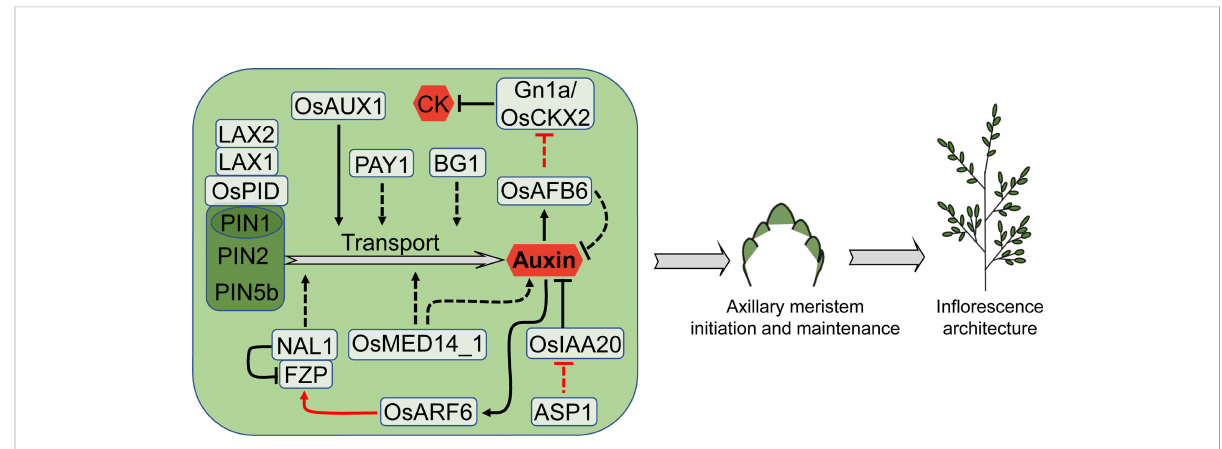
FIGURE 5 Factors involved in auxin-mediated regulation of rice in fl orescence architecture. Auxin plays a vital role in axillary meristem initiation and maintenance at both vegetative and reproductive stage. PINs-mediated auxin transport is a crucial process for auxin function. Auxin also interacts with CK in determining rice in fl orescence architecture. Arrows and blocked arrows represent positive and negative regulation, respectively. Solid and dashed lines represent direct and indirect regulation, respectively. Red and black lines represent regulation between factors at transcriptional and protein level, respectively. CK,